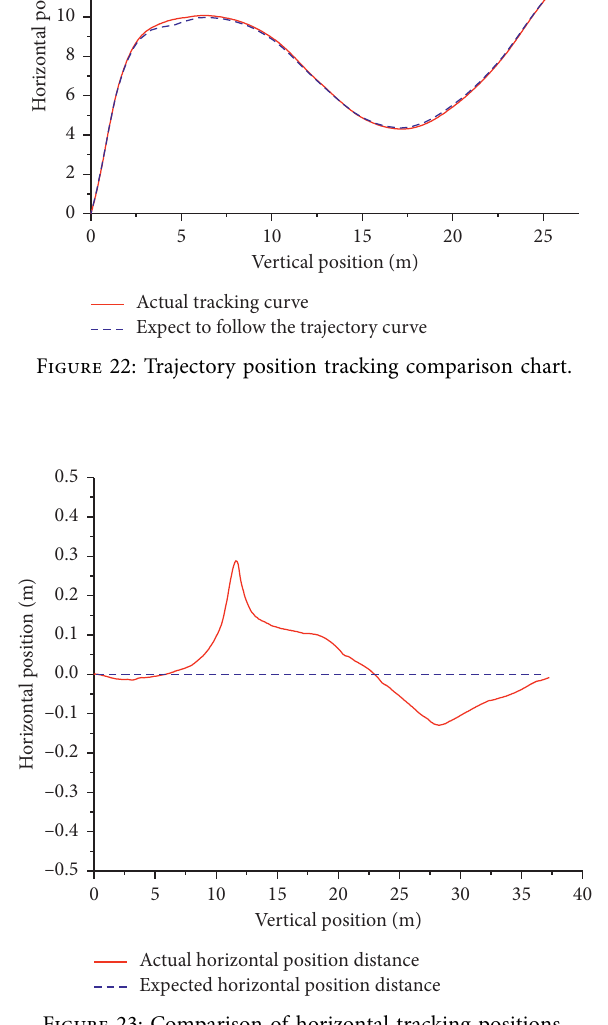
Figure 23: Comparison of horizontal tracking positions.